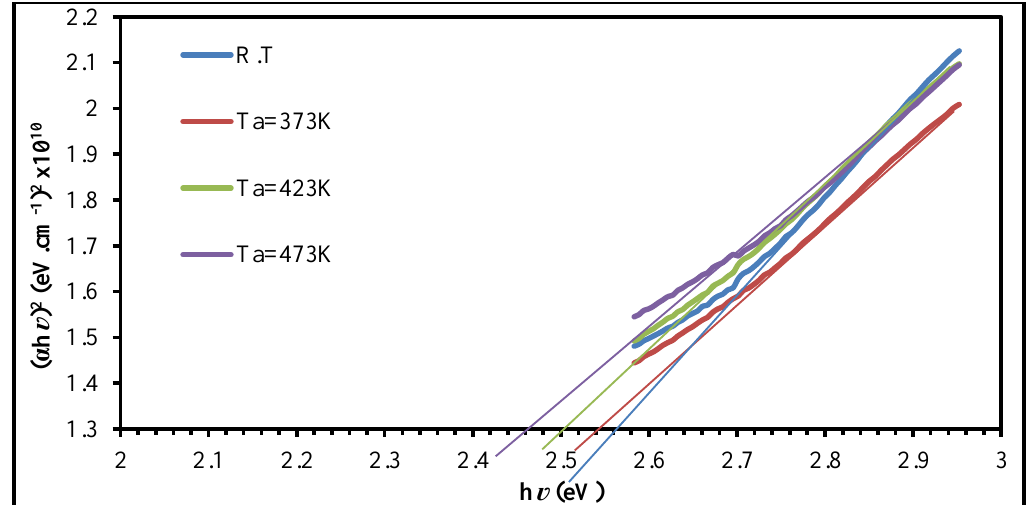
Fig. 4: (αhʋ) 2 versus photon energy of incident radiation for as-deposited and annealed Alq :C thin films (100: 1) at different 3 60